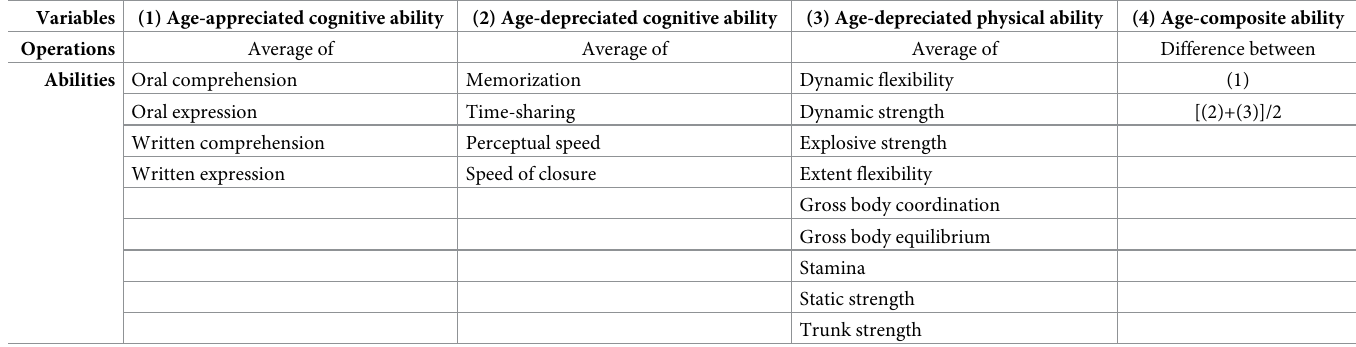
Table 1. Variable